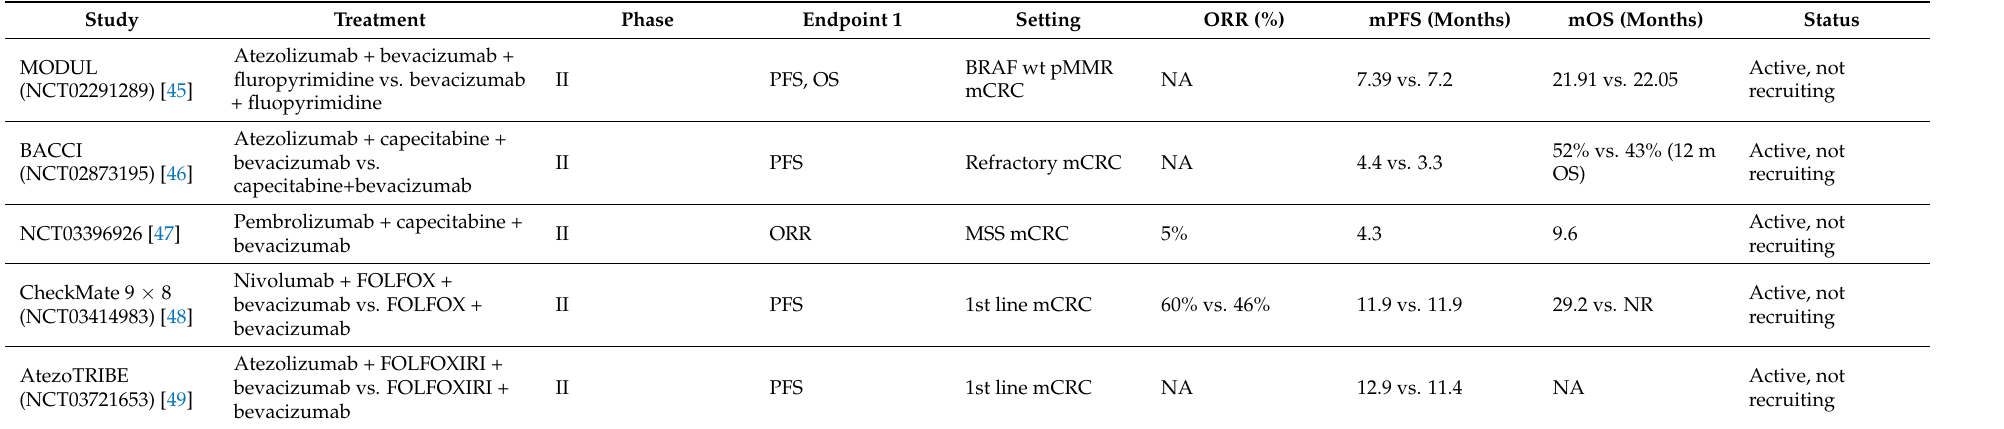
Table 2. Currently ongoing and completed clinical trials of anti-VEGF, CT, and ICIs in MSS